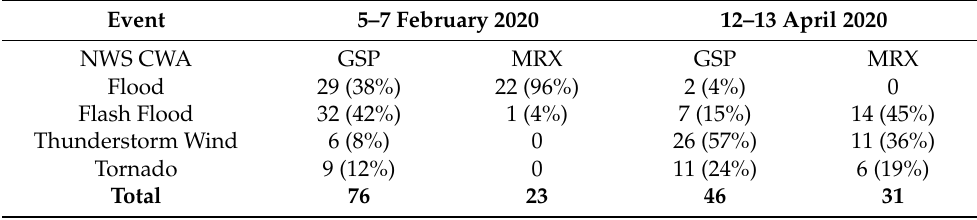
the 5–7 February and 12–13 April 2020 heavy rainfall events within the County Warning Area (CWA) of the Greer, SC office (GSP) and the Morristown, TN office